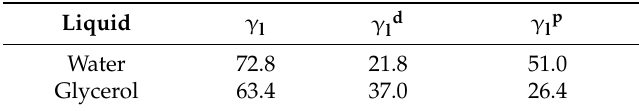
Table 2. Dispersion and polar contributions to liquid surface tension.